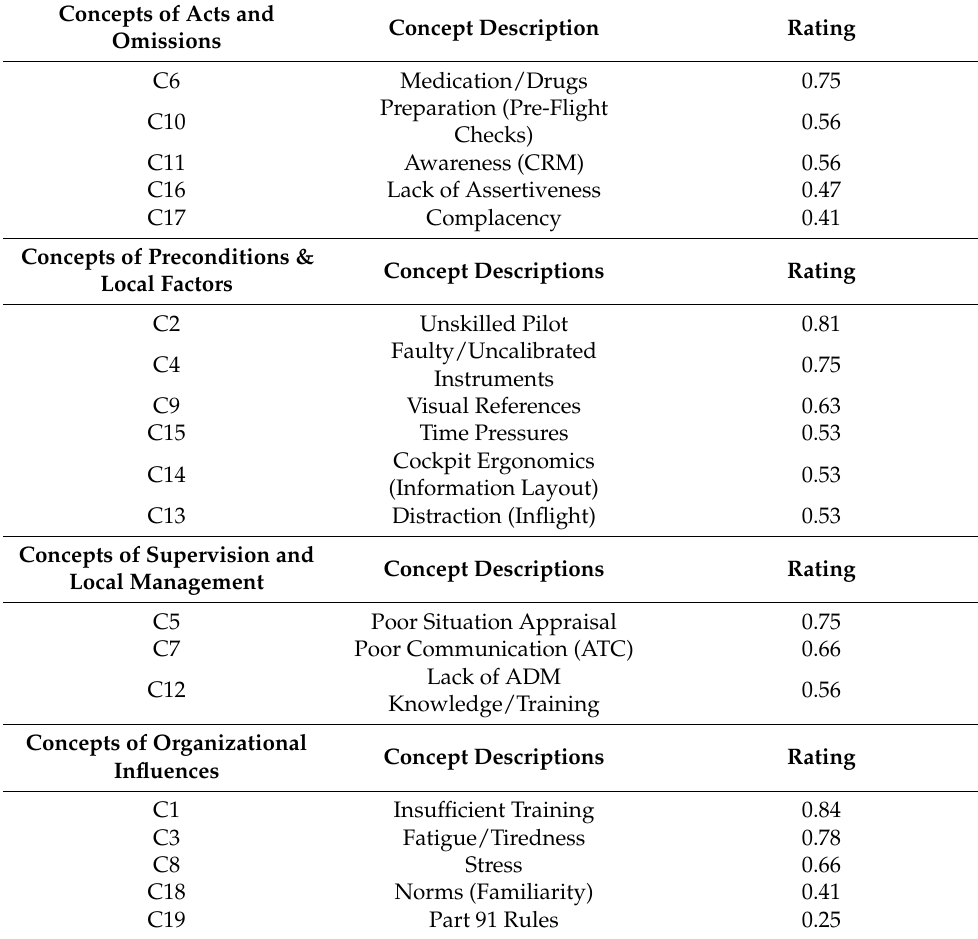
Table 4. Rated startle drivers’ subgroupings based on HFACS